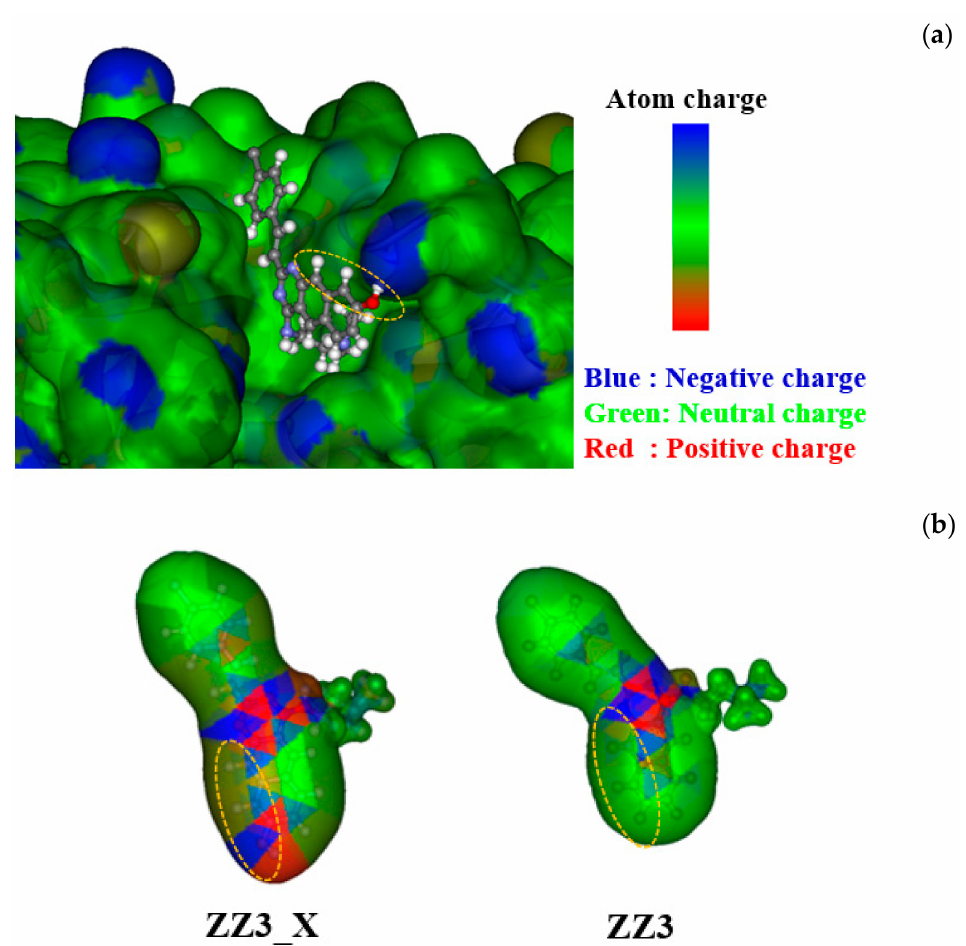
Figure 7. ( a ) Conformations of ZZ3 and ZZ3_X bound to the ligand-binding pocket of FtsZ, and ( b ) charge distributions for ZZ3 and ZZ3_X. The part enclosed by a yellow ellipse is a replaced part of D-part of